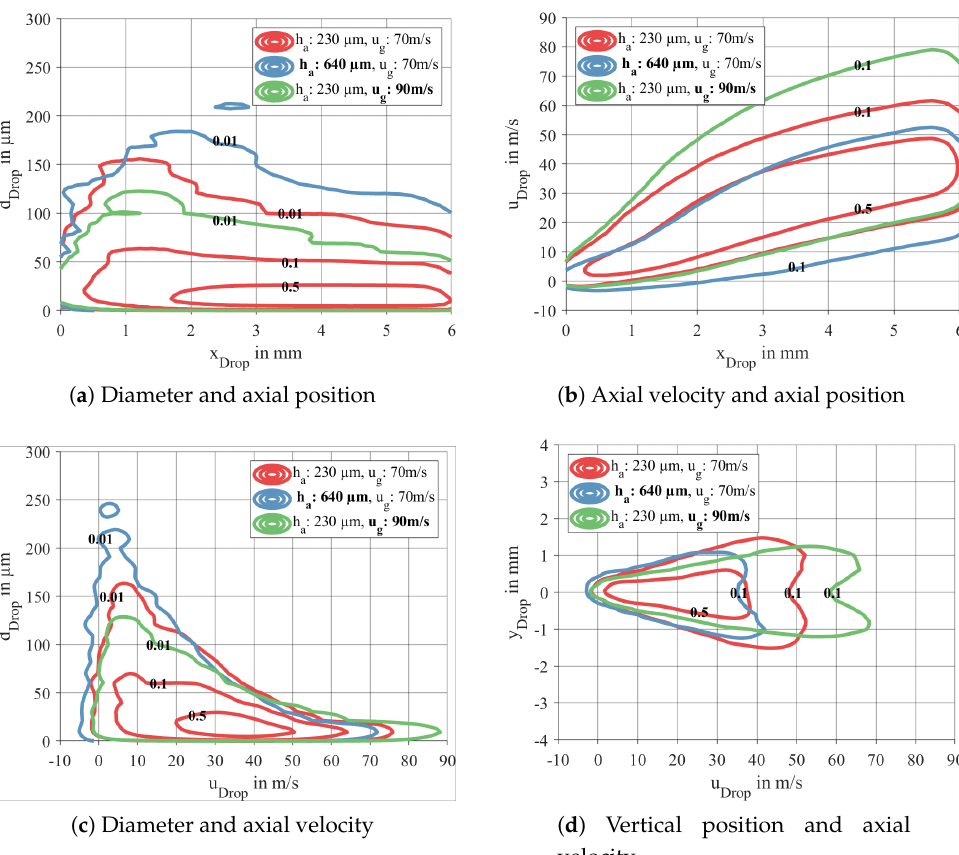
Figure 16. Effect of gas velocity and prefilmer geometry on the interdependencies of the spray quantities for p g = 5bar.